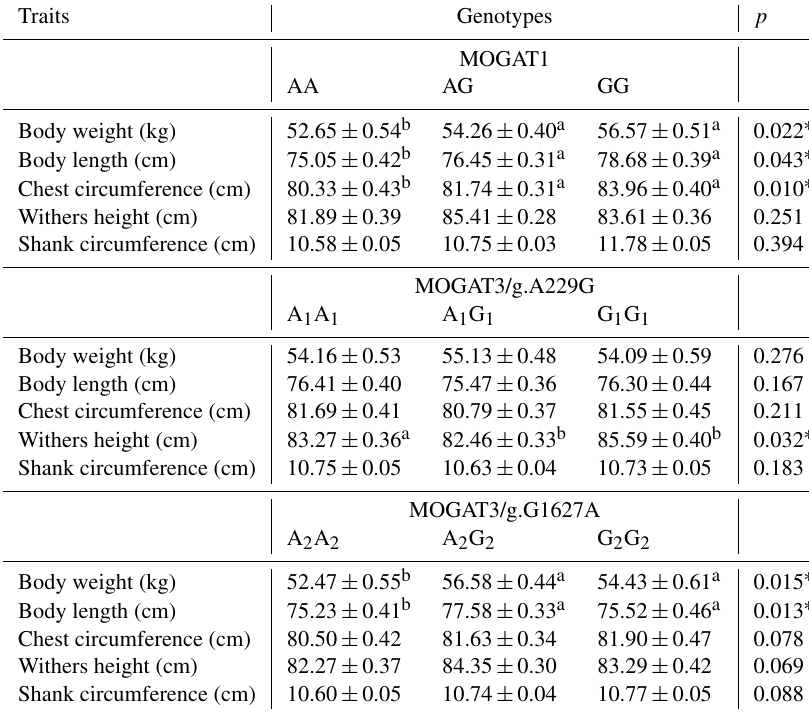
Table 3. Association analysis of genotypes and growth traits according PROC